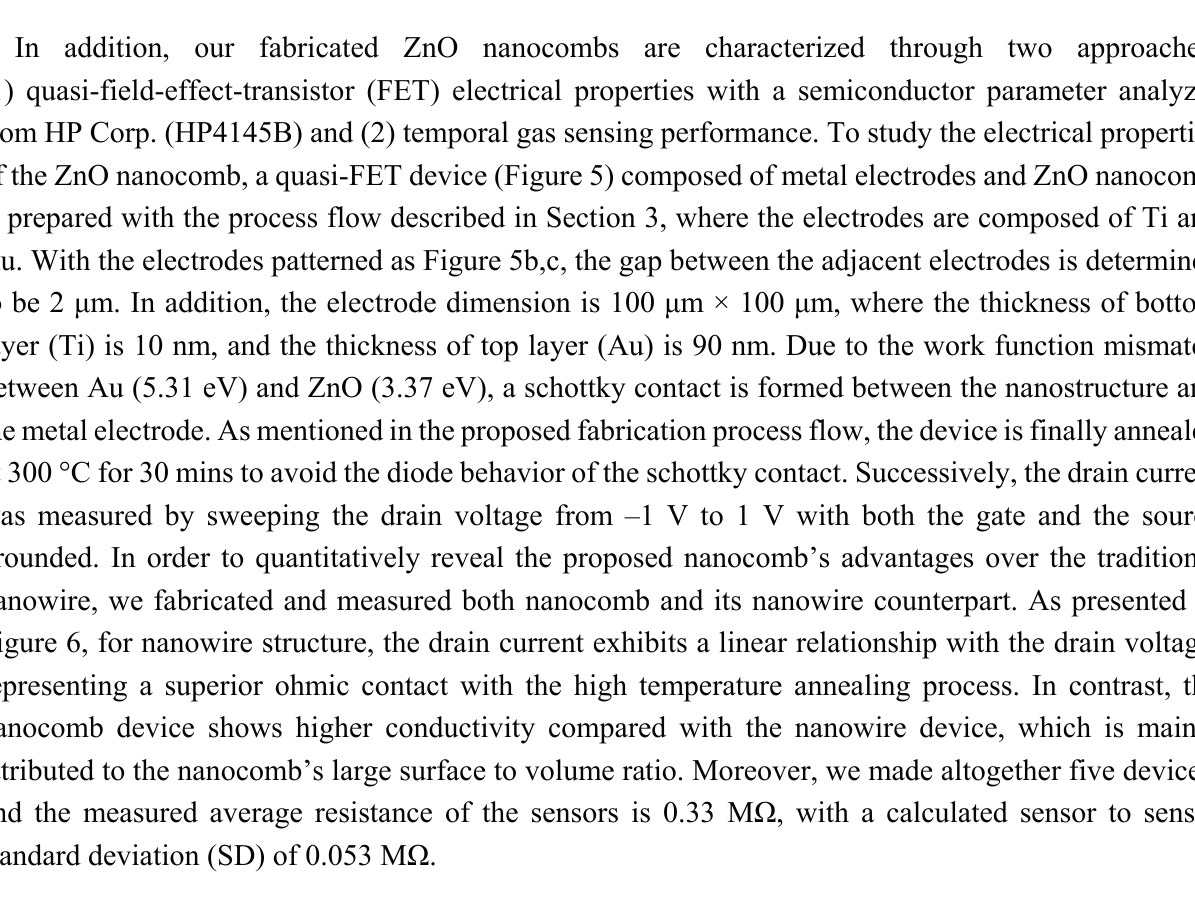
Figure 4. ( a ) The SEM picture of the fabricated ZnO nanocombs; ( b ) XPS characterization of the fabricated ZnO